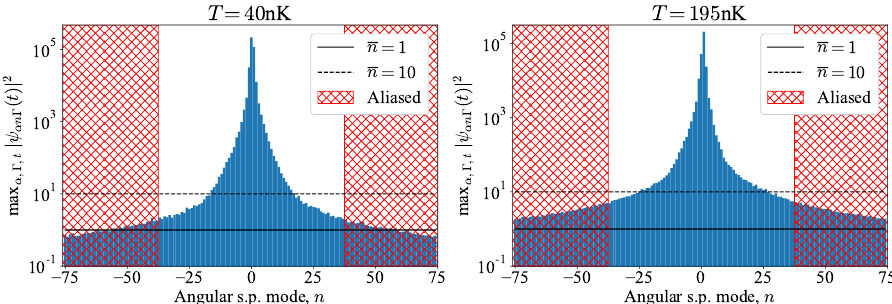
Figure 13: Maximum average occupation of the angular single-particle modes with a given n index, in simulations of the full experimental sequence for tempera- = 0.78 µ and tures T = 40nK and T = 195nK, with respective barrier heights V b = 0.67 µ . For a grid with n = 150 points, modes in the red hatched region are V θ b formally subject to aliasing. The aliased modes have a maximum occupation on the order of 1, and are never occupied by 10 or more